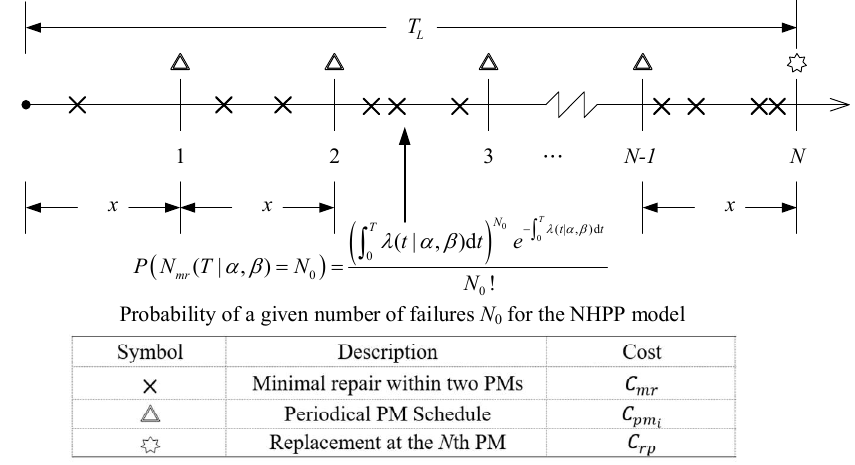
Figure 1. Timeline of the preventive maintenance model of an equipment or facility.